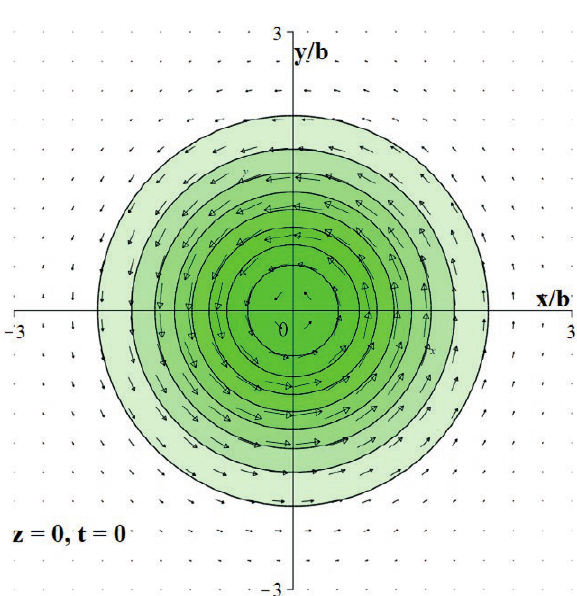
Figure 1. Focal plane section through a Gaussian spinor wavepack- et, at t =0. The contours give the probability density, the arrows the transverse current density (the longitudinal current is not shown). The direction of motion is out of the page. The transverse current density is purely azimuthal at this